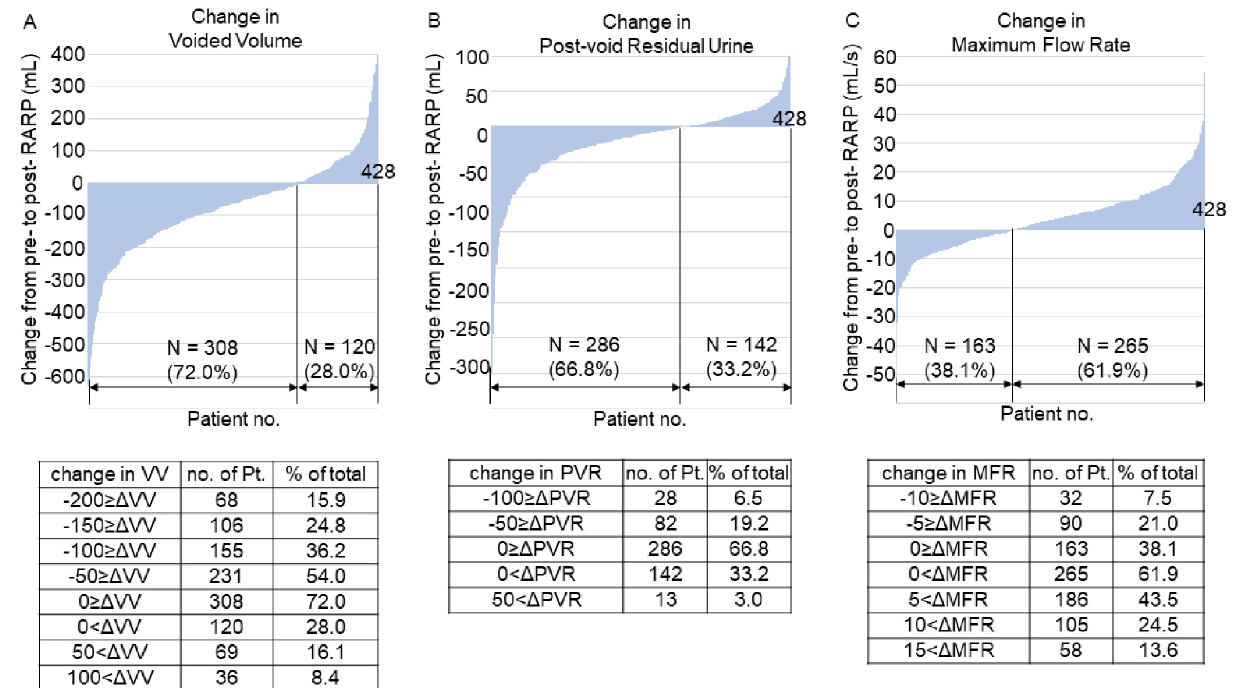
Fig 2. Changes between pre- and post-RARP uroflowmetry parameters. Waterfall plots of changes in (A) voided volume, (B) post-void residual urine, and (C) maximum flow rate. The tables below detail the exact number of patients and percentage of total in groups stratified by values of clinical significance. Abbreviations RARP: robot-assisted radical prostatectomy, Δ VV: perioperative change in voided volume, Δ PVR: perioperative change in post-void residual urine, Δ MFR: perioperative change in maximum flow rate.